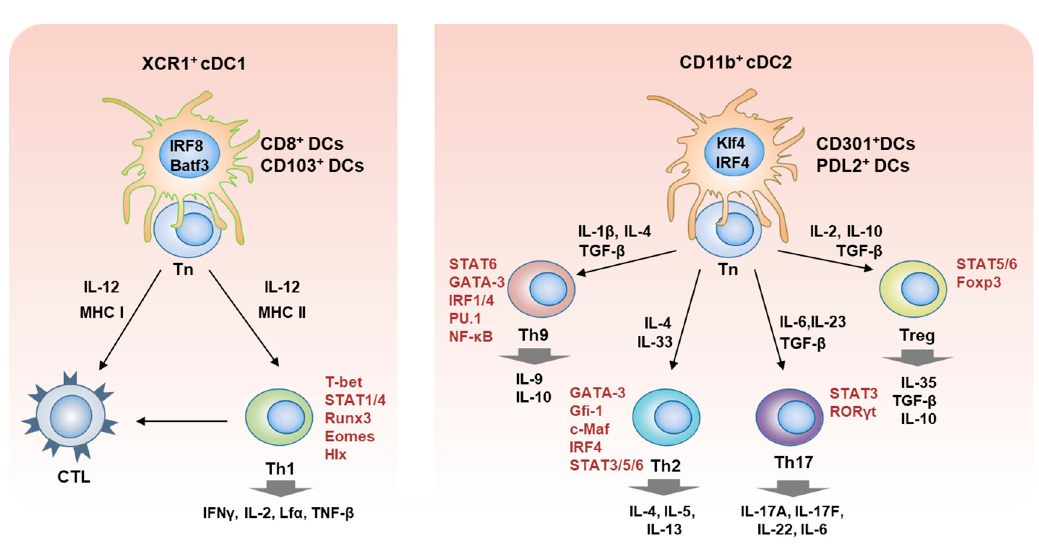
Figure 2. Schematic diagram for the involvement of cDC1 and cDC2 subsets in the T cell development. The XCR1 + cDC1, having major transcription factors, IRF8 and Batf3, are involved in the differentiation of naïve T cells into cytotoxic T lymphocytes (CTL) and Th1 cells with the cDC1 cytokine, IL-12 (left). Whereas, CD11b + cDC2 known by their IRF4 and Klf4 facilitate the T cell development into Th2, Th9, Th17, and Treg cells with cDC2 cytokines (right). Key transcription factors mediating the development of each T cell subset are indicated in red. Each T cell subset secretes the effector cytokines as described.